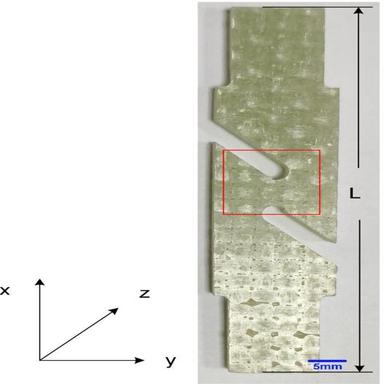
Shear area of sample.